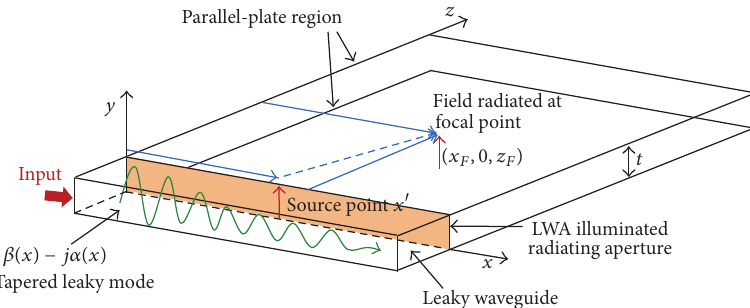
Figure 8: A tapered rectilinear leaky-wave antenna embedded between two metallic planes, to implement 2D focusing in the 𝑥𝑧 -plane.